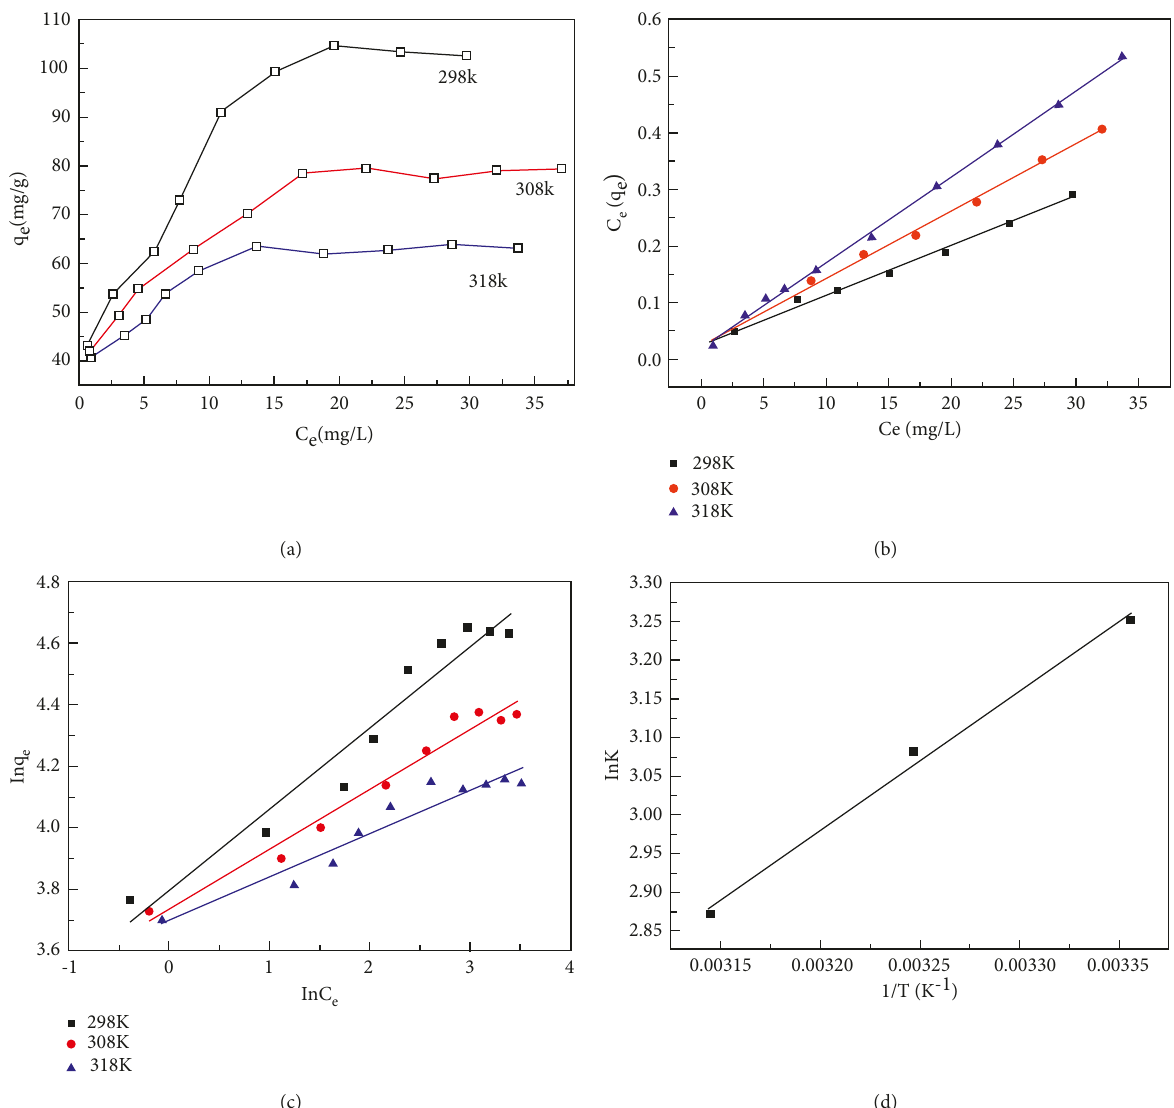
Figure 5: (a) Effect of temperature on Cr (VI) removal (pH � 2, m / V � 0.1g/L); (b) Langmuir and (c) Freundlich isotherm curves; (d) ln K as a function of 1/ T .